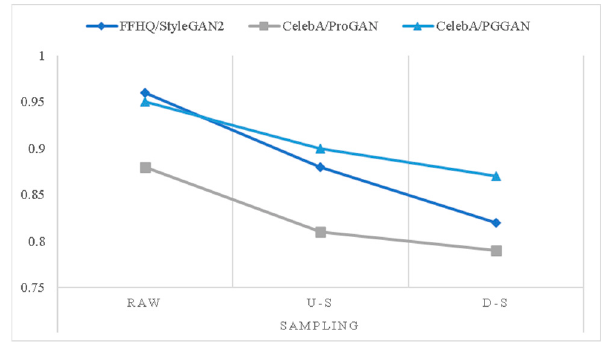
Figure 9. The line chart from Table 7.